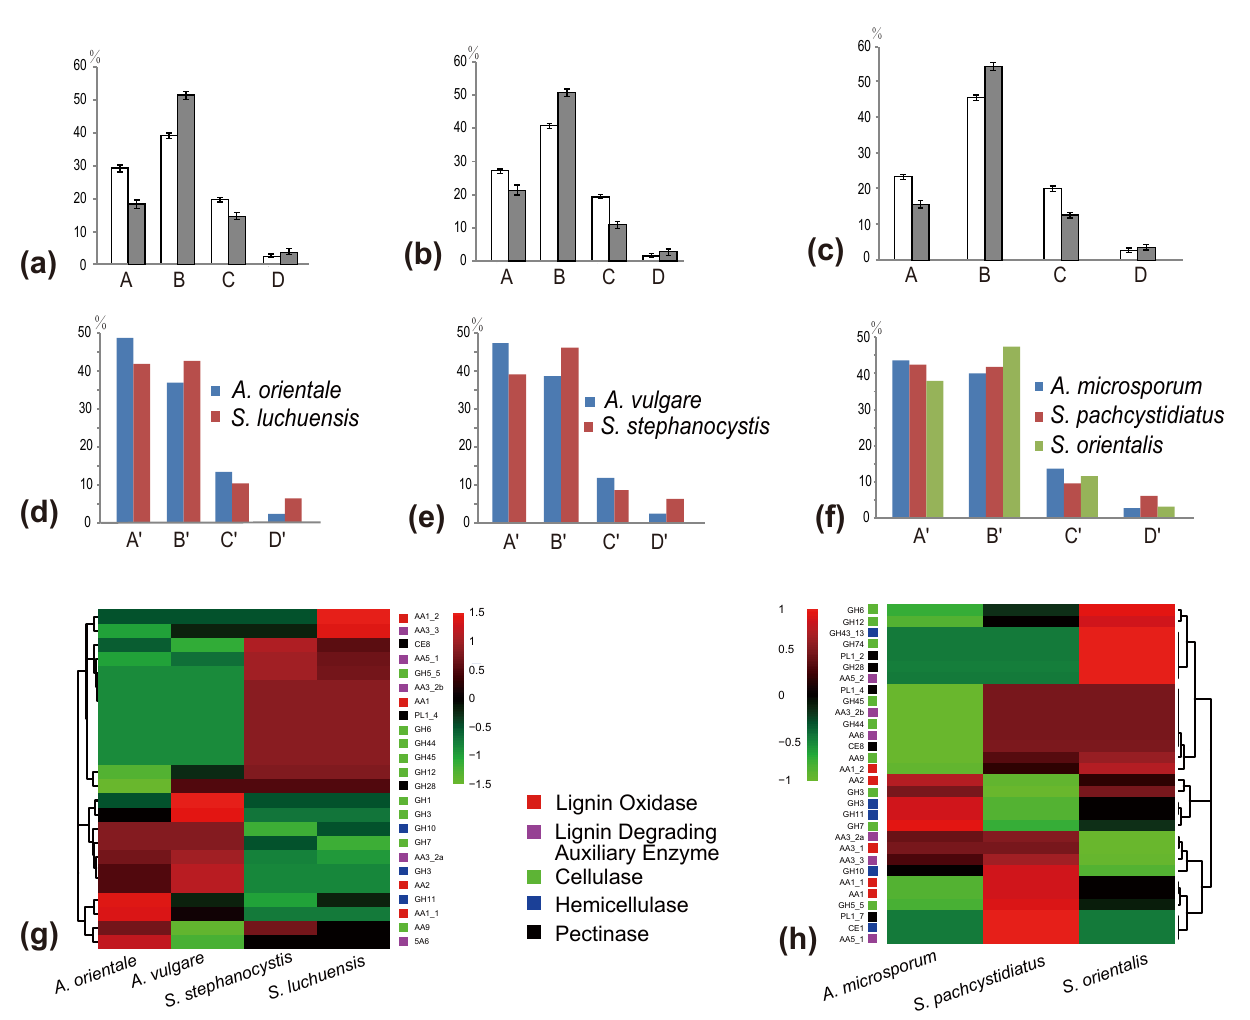
Figure 4. The changes of four major chemical components of cones before and after decomposition, and the relationship to differences of the numbers of lignocellulolytic genes between Strobilurus and Auriscalpium fungi colonizing the same pinecones. ( a ) The proportion of four components in cones of P. yunnanensis before and after the decomposition by A. orientale . A, B, C and D in x -axis represent lignin, cellulose, hemicellulose and pectin, respectively. The y -axis represents the proportion of the four components. White represents undecomposed cones, while gray represents decomposed cones. the same below. ( b ) The proportion of four components in cones of P. sylvestris before and after the decomposition by A. vulgare . ( c ) The content changes of four components in cones of P. armandii before and after being decomposed by A. microsporum . ( d ) Comparison of lignocellulolytic genes. A’, B’, C’ and D’ in x -axis represent ligninase, cellulose, hemicellulose and pectinase, respectively. The y -axis represents the proportion of the four types of enzymes in A. orientalis and S. luchuensis grown on cones of P. yunnanensis . The same below. ( e ) Comparison of lignocellulolytic genes in A. vulgare and S. stephanocystis on cones of P. sylvestris . ( f ) Comparisons of lignocellulolytic genes of A. microsporum , S. pachcystidiatus and S. orientalis grown on cones of P. armandii. ( g ) Heatmap analysis of lignocellulolytic genes of four fungi on cones of P. subgenus Pinus . ( h ) Heatmap analysis of lignocellulolytic genes of three fungi on cones of P. subgenus Strobus